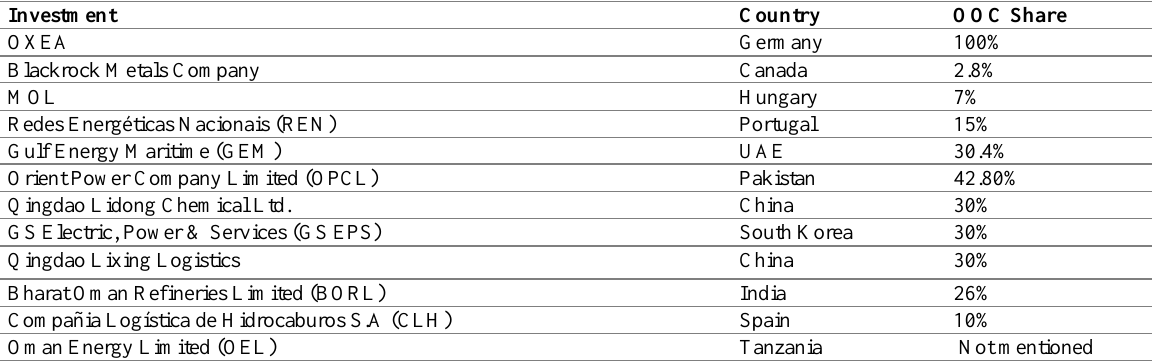
Table 6: Selected International Investments of Oman